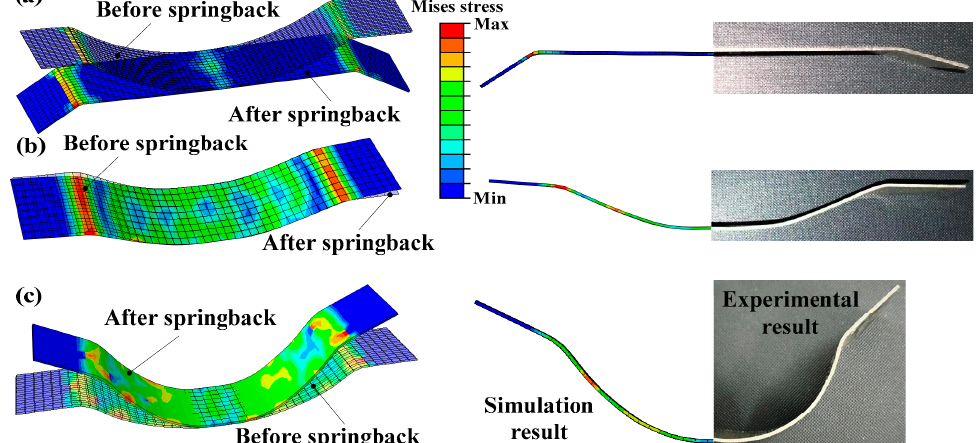
Figure 18. Simulated and experimental springback results of Ti-6Al-4V arc-bent parts under IHF [116]. Reprinted with permission from Ref. [116]. Copyright 2022, International Deep-Drawing Research Group Conference. ( a ) Conventional arc-bending with velocity of 0.1 m/s, ( b ) IHF with velocity of 43 m/s and ( c ) IHF with velocity of 65 m/s.